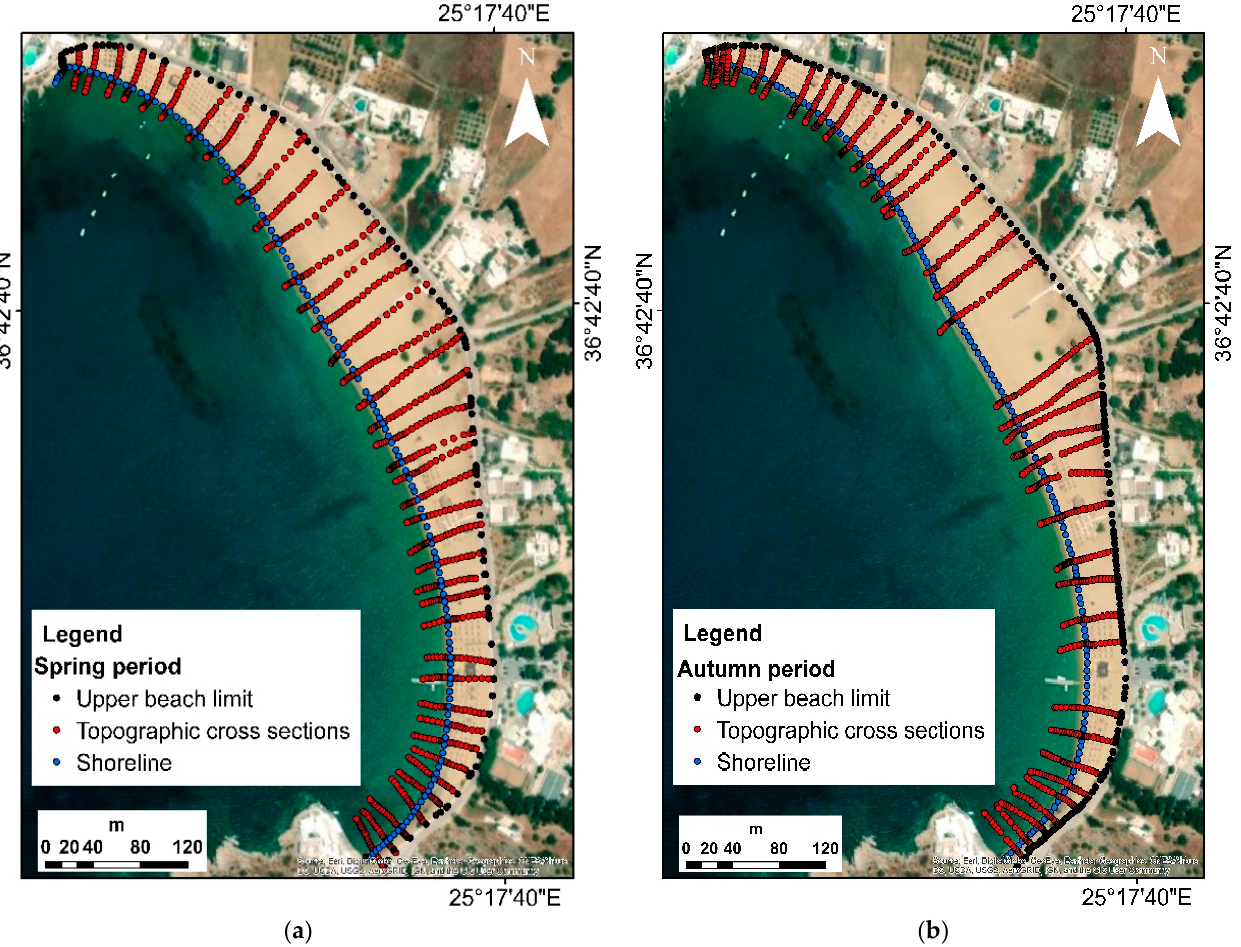
Figure 4. Mylopotas beach map. All dots are indicating DGPS measurement points: black dots indicate the inland beach limit, red dots indicate vertical cross sections in relation to shoreline, blue dots indicating the coastline during fieldwork period. ( a ) Spring profile fieldwork measurements (41 cross-sections). ( b ) Autumn profile fieldwork measurements (40 cross-sections) profile.